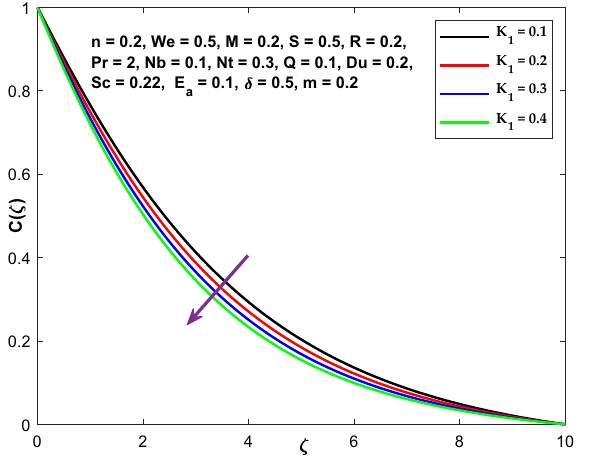
Figure 23. Character of K 1 versus C (ζ) .